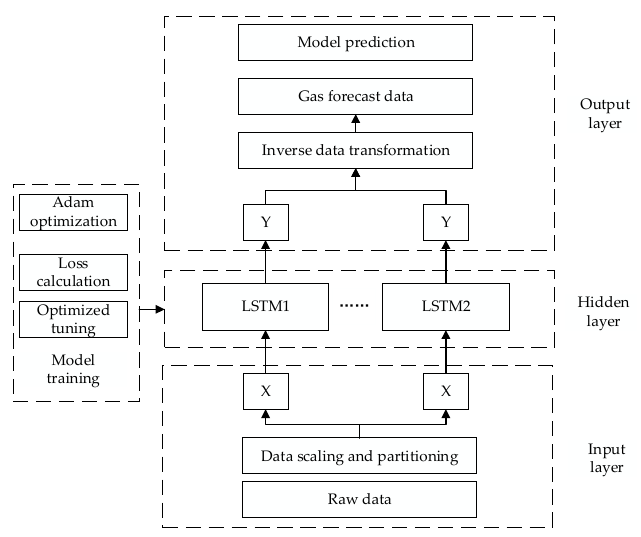
Figure 3. LSTM gas prediction model framework.